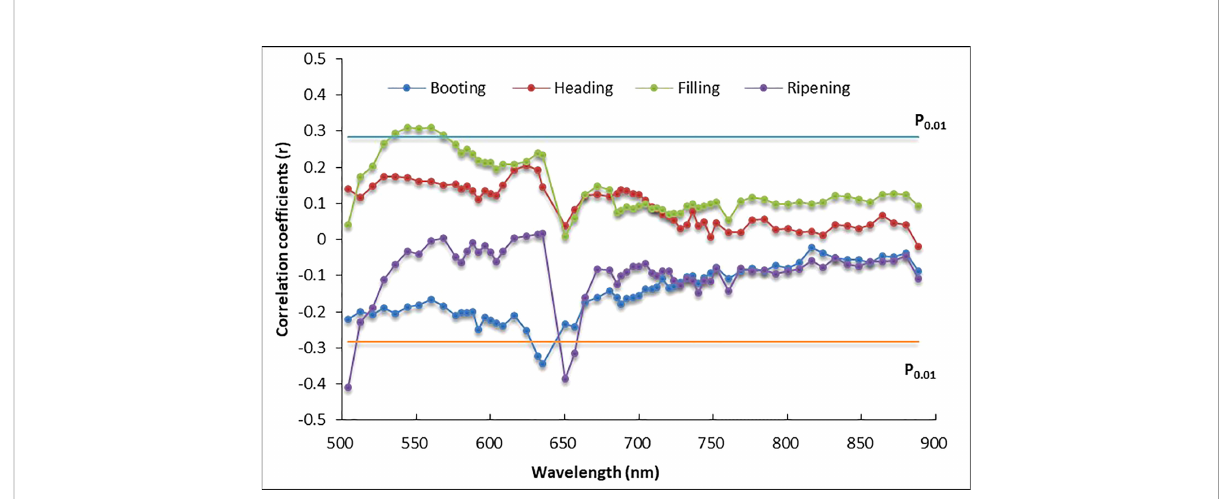
FIGURE 2 Correlation coef fi cients between rice amylose content (AC) and re fl ectance of unmanned aerial vehicle (UAV)-based hyperspectral images.